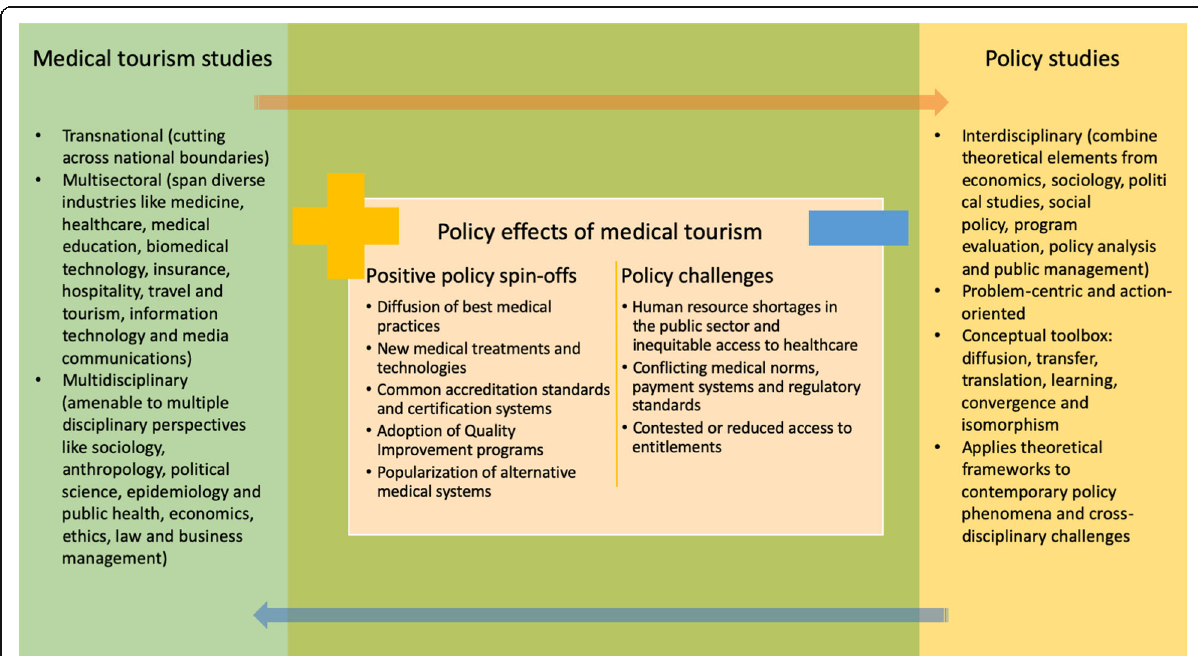
Fig. 1 The intersection of medical tourism and policy